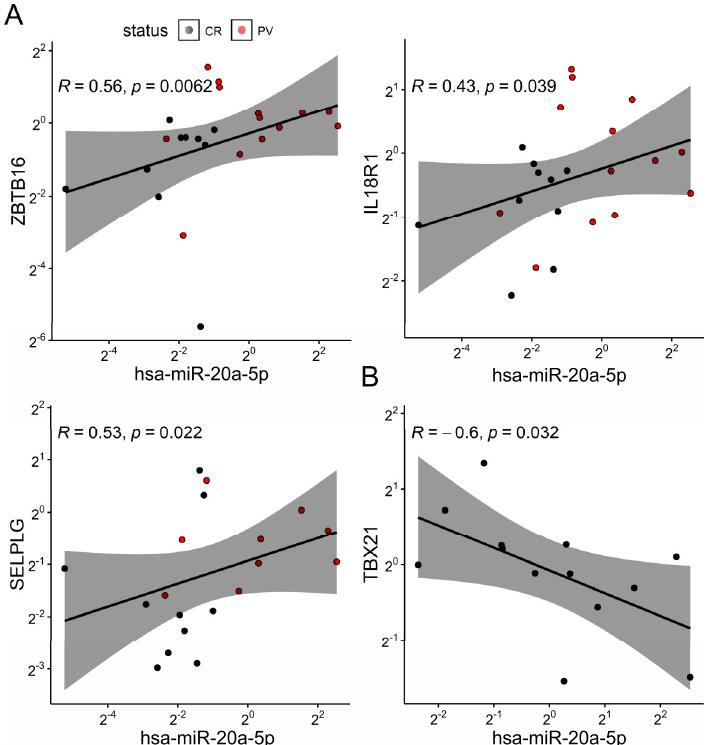
Figure 3. ( A ) Scatter plot representing relations between the hsa-miR-20a-5p expression and some of the gene markers used in the pooled sample (bulk γδ blood T cells, fold change, ΔΔCt method). Dots are colored according to their group membership (controls/CR black, cases/PV red). ( B ) Scatter plot representing the association between the hsa-miR-20a-5p and the TBX21 expression in controls ( n = 13). Both axes are log-scaled. R denotes the Spearman’s correlation coefficient; each dot represents one donor. The black line represents a linear model fit (least squares method), whereas the shaded region indicates the 95% confidence interval.